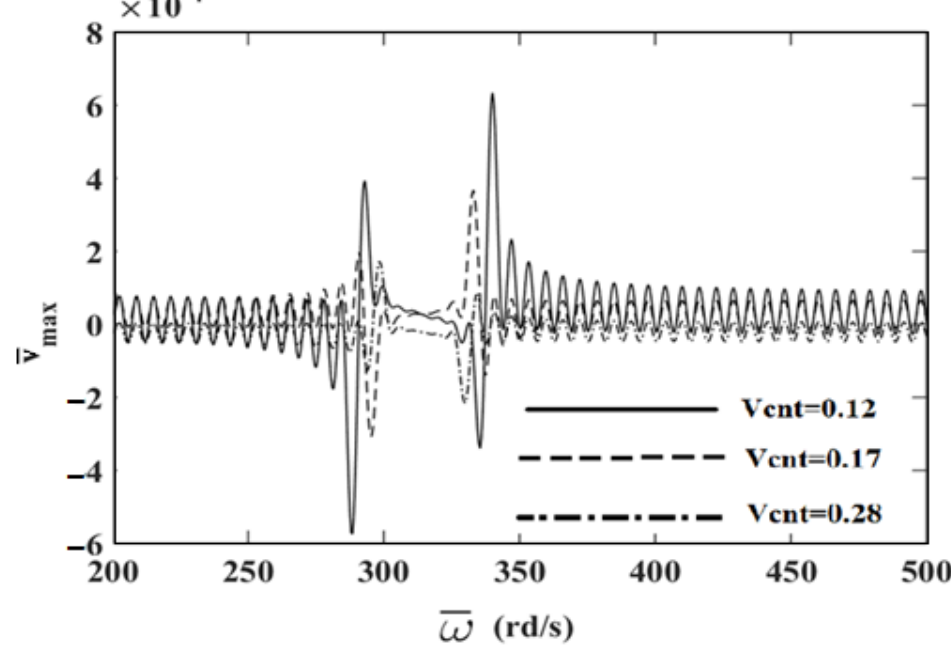
Figure 9. The relationship between the displacements and the frequency of the dynamic load ( 𝑤̅ ) in the simply supported Ʌ -Beam for different values of V CNT .